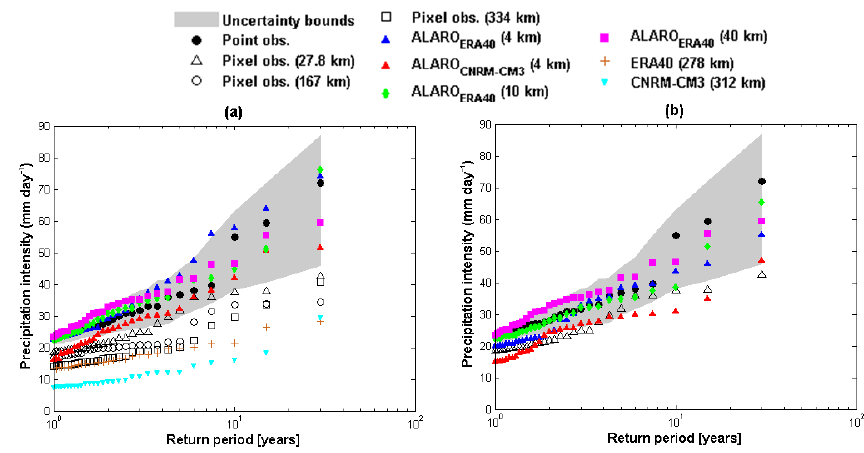
Figure 3. Validation of the native (a) and aggregated (b) daily precipitation quantiles (1961–1990) for the ALARO model and its driving GCM or reanalysis data based on Uccle observations, for the summer season (shaded areas show at-site confidence intervals for the point observations using the bootstrap-based 95% confidence intervals).